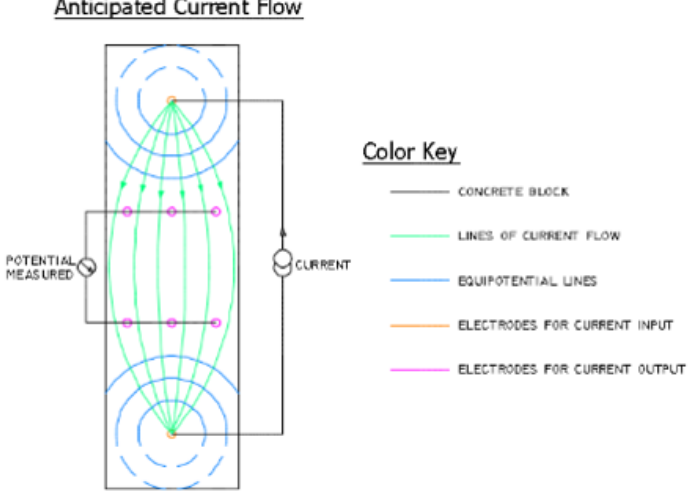
Figure 4. Anticipated Current Flow and Locations of Electric Potential Measurements.